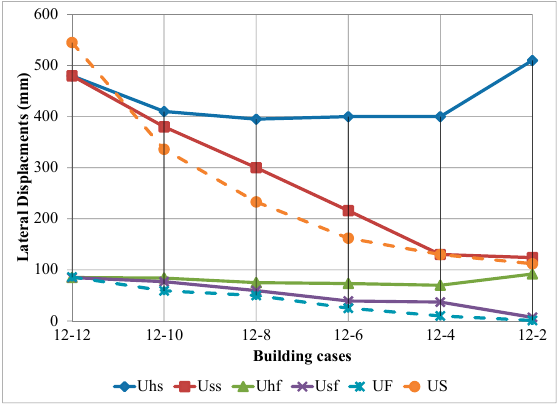
Figure 5. Top lateral displacements in buildings with different configurations.